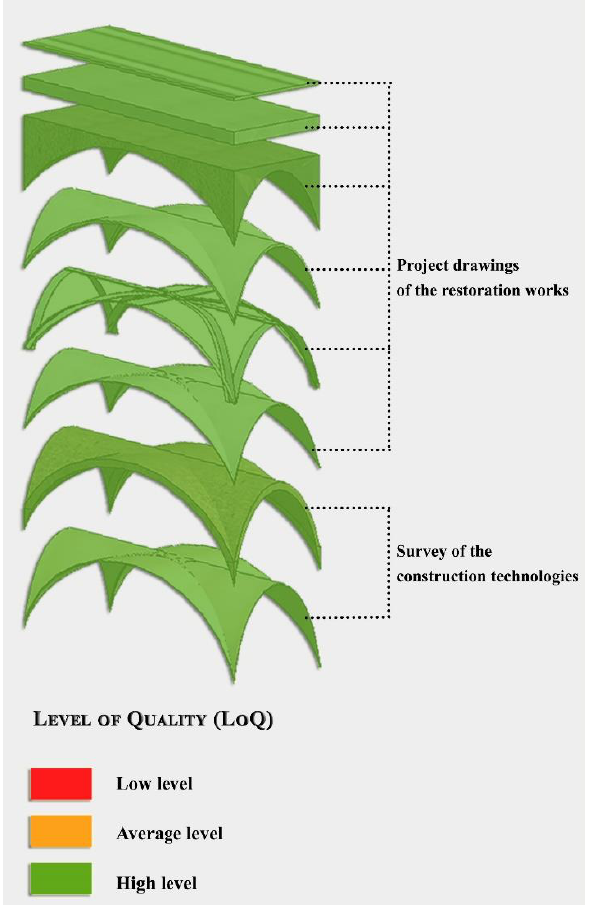
Figure 6: Level of Quality (LoQ) of the model of a vault of